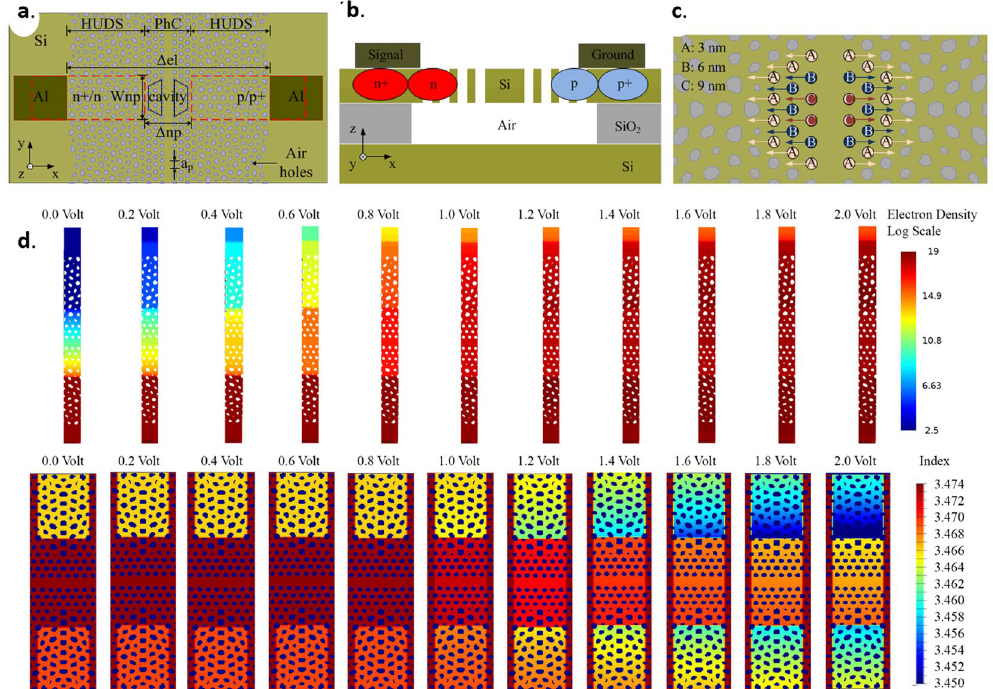
Figure 5. ( a ) A schematic of resonant modulators clad with HUDS in p + pinn + configuration. The top view illustrates waveguide-coupled cavity clad with HUDS, and positions of doping regions. ( b ) Side view of the device illustrating approximate distributions of p (Boron) and n (Phosphorus) dopants. ( c ) HUDS resonant cavity design. ( d ) Top: Pseudo-color display of simulated electron density (log scale in C·cm − 3 ) and bottom: the pseudo-color display of simulated index of refraction distribution (linear scale) for the p + pinn + device as a function of the magnitude of the applied